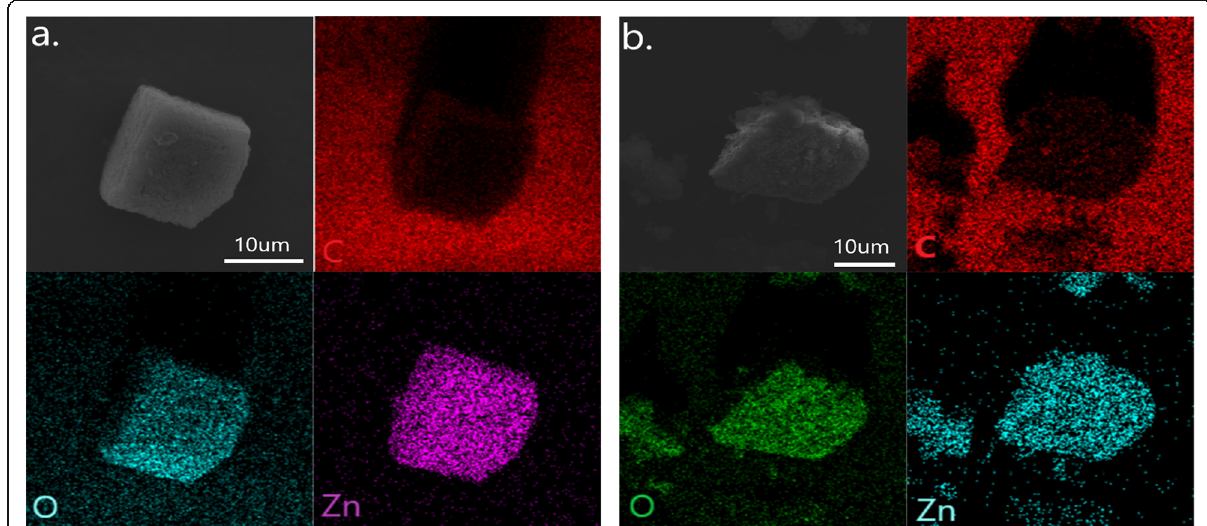
Fig. 4. EDS mapping images of a MOF-5 and b GO@MOF-5